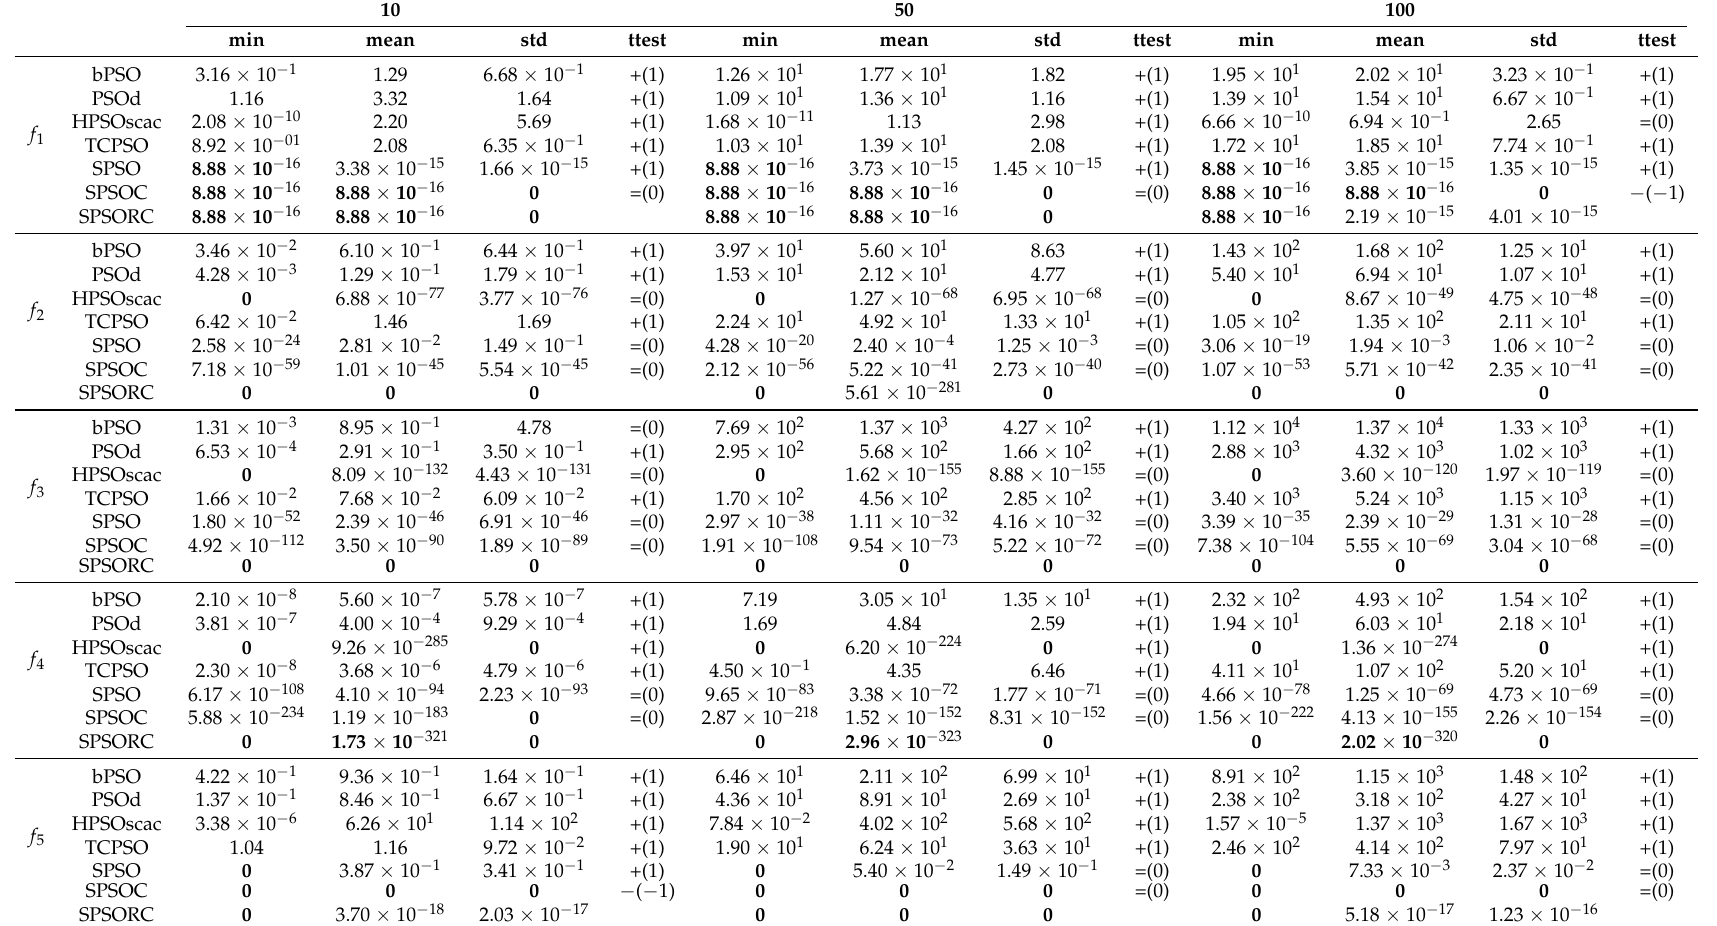
Table 6. Optimization results for the function in 3 kinds of